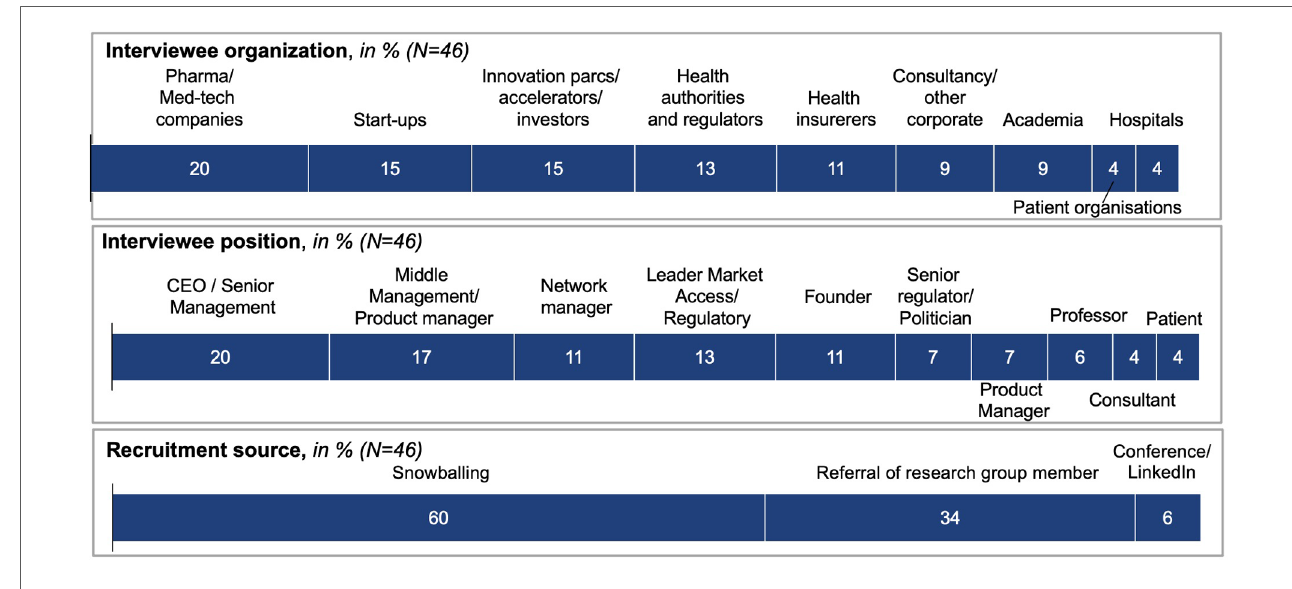
FIGURE 3 Mind-map participants — background and study